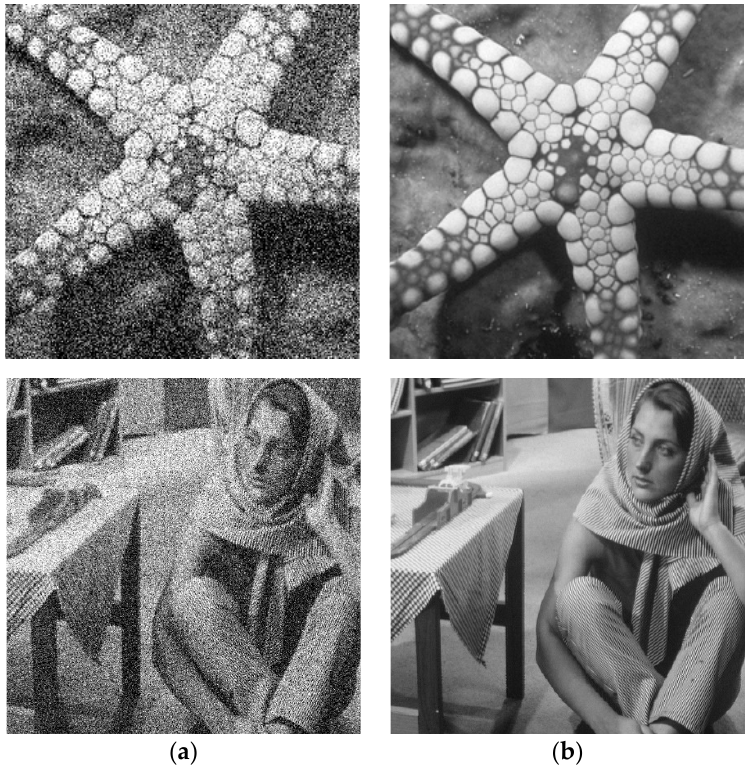
Figure 8. Image denoising comparison under high noise σ ( σ s = 9.0 × 10 − 1 , σ r = 3.0 × 1). ( a ) High noise image. ( b ) Denoising image.